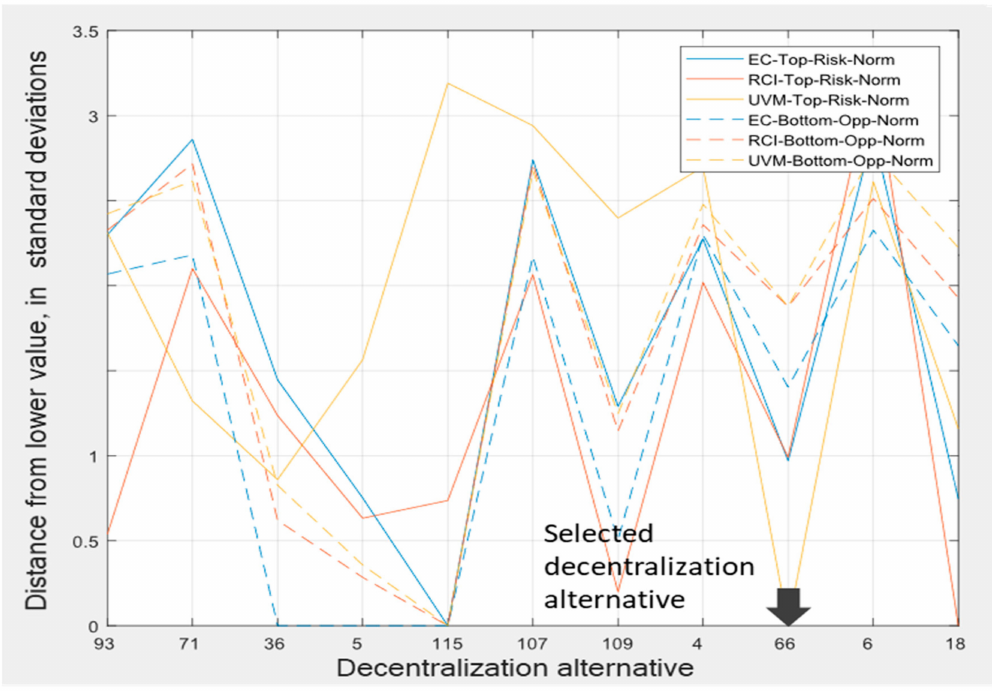
Figure 10. Implementation risks and opportunities borne by the representative decentralization